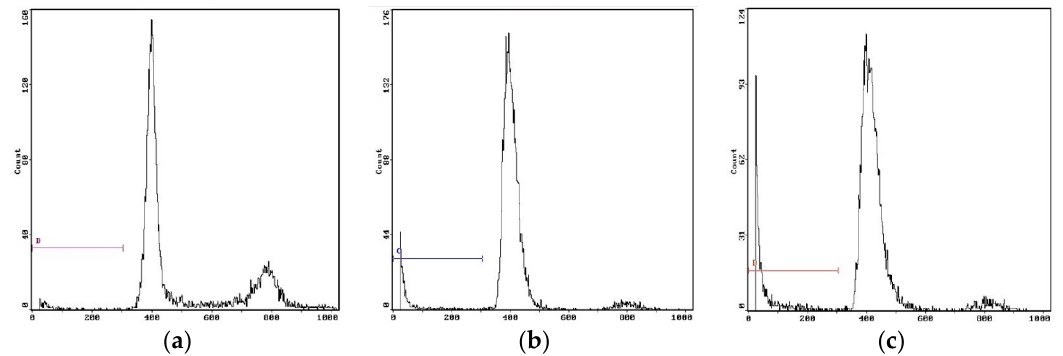
Figure 10. Flow cytometric analysis of DNA fragmentation. ( a ) Control, 0 h. ( b ) Cells treated with EPS-3a for 24 h. ( c ) Cells treated with EPS-3a for 48 h.